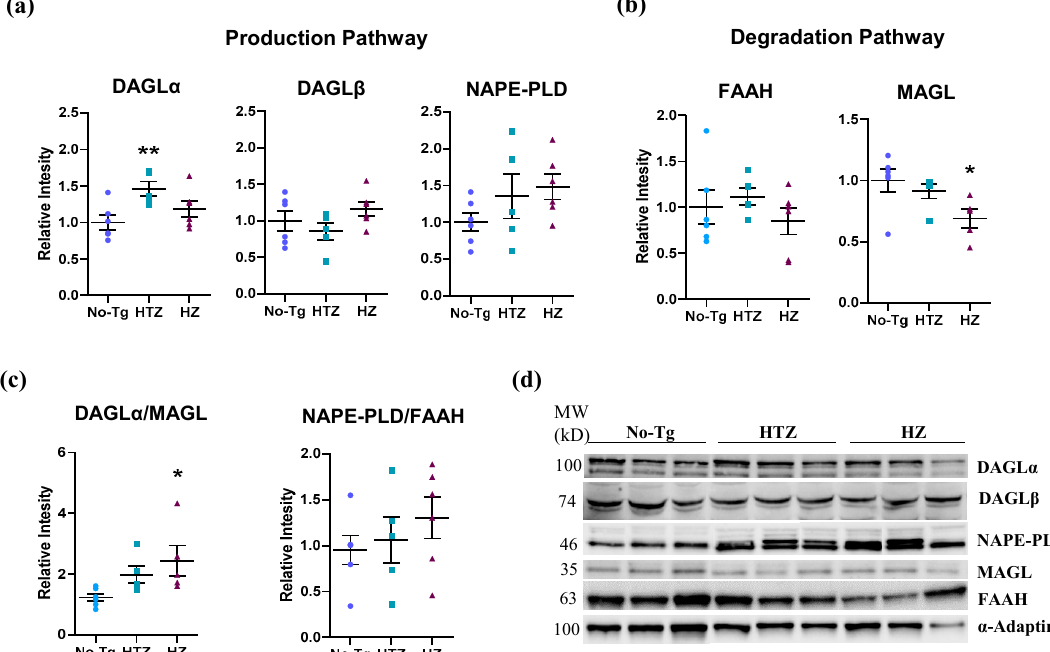
Figure 4. Production and degradation pathways in 5xFAD transgenic mice. Bar charts in ( a , b ) represent the quantification of western blot membranes ( d ) after incubating with anti-diacylglycerol lipase alpha (DAGL α ), DAGL β , N -acyl phosphatidylethanolamine-specific phospholipase D (NAPE-PLD), fatty acid amide hydrolase (FAAH), and monoacylglycerol lipase (MAGL) antibodies and normalized with α -adaptin. Bar charts in ( c ) are the ratio between DAGL α and MAGL and between NAPE-PLD and FAAH, both previously normalized with α -adaptin. We performed the Western blot analysis on hippocampus homogenates. The blots shown in ( d ) are a representation of all the bands (see Figures S2 and S4, Supplementary Materials, for additional information), resulting from three out of six independent samples (three out of five for the HTZ group). Molecular weights (MW) are indicated in kilodaltons (kDa). One-way ANOVA and Tukey’s test were performed: (*) p < 0.05 and (**) p < 0.01 vs. No-Tg group. Histograms represent the mean ± SEM ( n = 6).